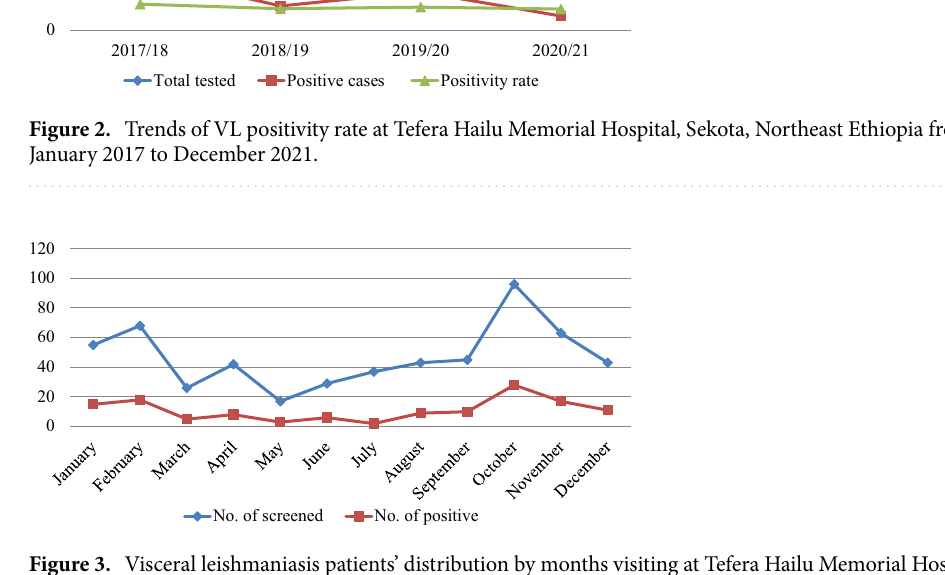
Figure 3. Visceral leishmaniasis patients’ distribution by months visiting at Tefera Hailu Memorial Hospital, Sekota, Northeast Ethiopia from January 2017 to December 2021.